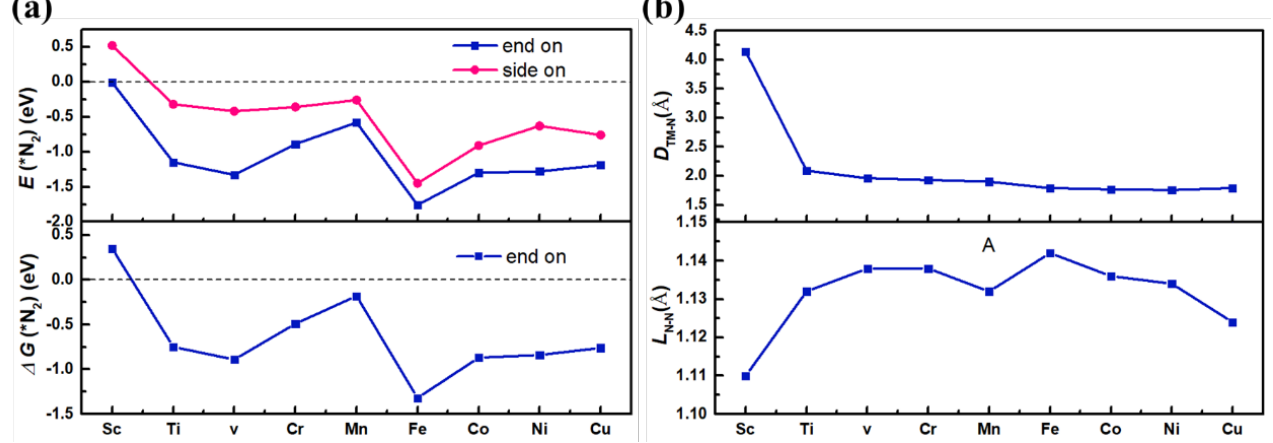
Figure 2. ( a ) E ads (*N 2 ) and ΔG(*N 2 ) of an N 2 molecule on TM@g-C 3 N 4 , ( b ) D TM-N and L N-N of TM@g- C 3 N 4